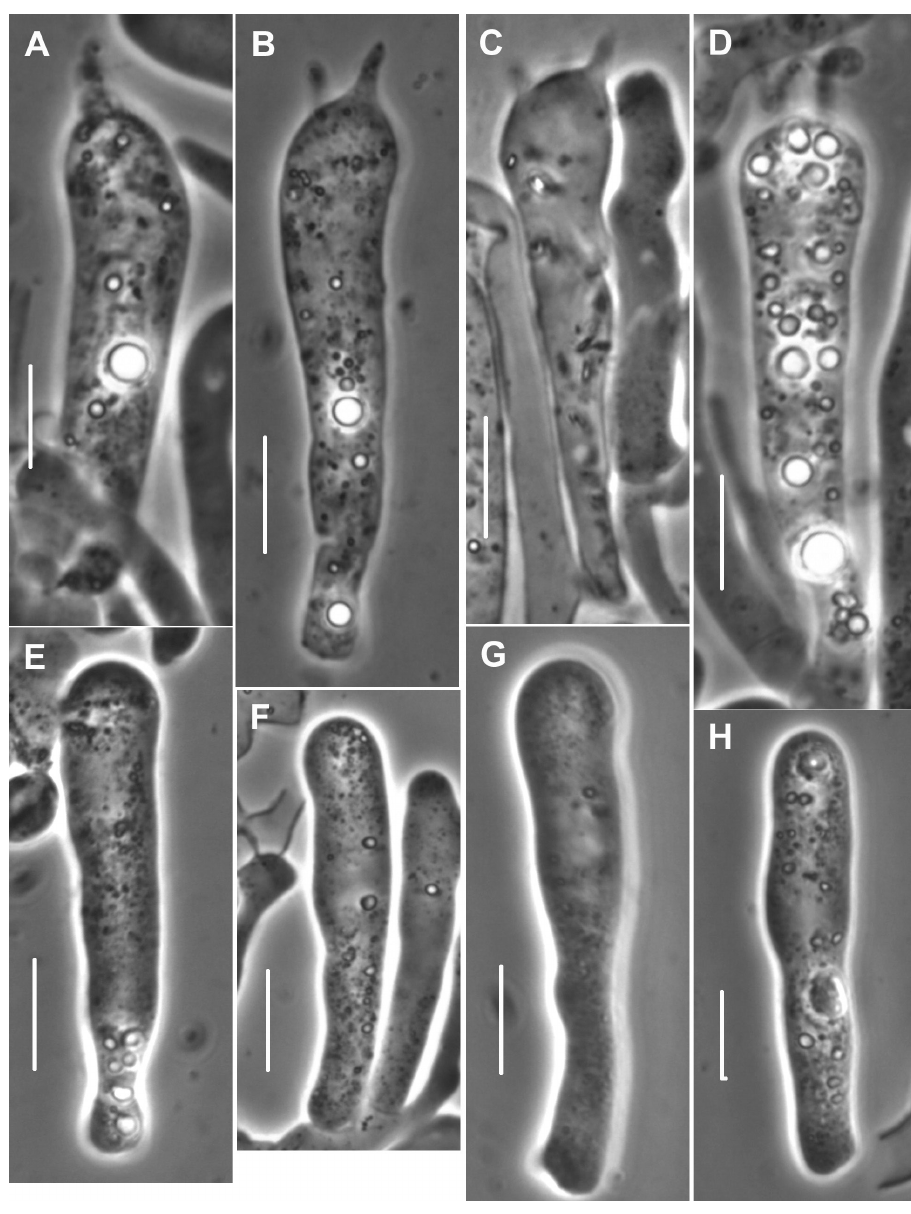
Figure17. Mycetinis applanatipes . Basidia and cheilocystidial structures. A Monosterigmatal basidium B, C 2-sterigmate basidia D 4-sterigmate basidium E–H Cheilocystidial structures. Standard bars = 10 µm. DED 6628 (SFSU-F-